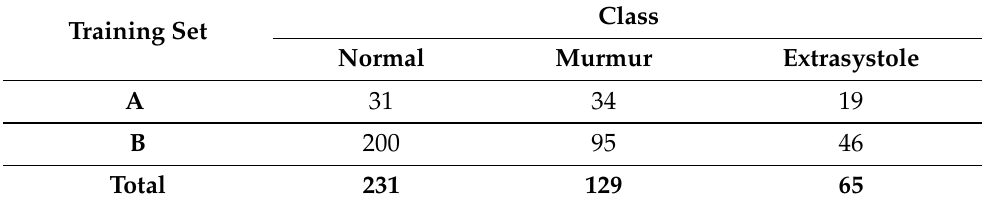
Table 2. Overview of pascal dataset